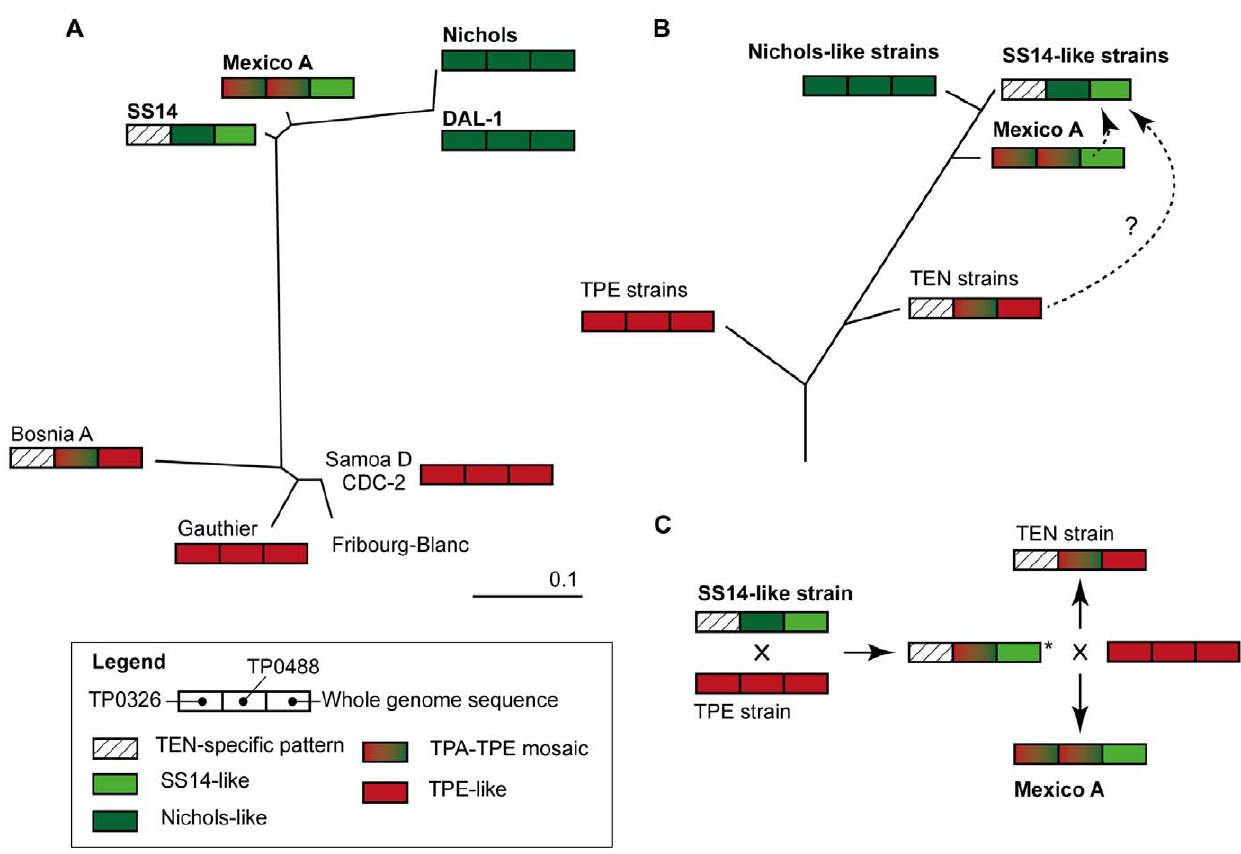
Figure 3. Evolutionary relationships among TP strains and hypothetical evolutionary schemes. A. Unrooted tree constructed from restriction target site data from 25.6% of the analyzed TP genomes (modified according to Sˇmajs et al. [18]). TPA (Dallas, Nichols, Mexico A and SS14), TPE (CDC-2, Gauthier and Samoa D), TEN (Bosnia A) strains and unclassified simian isolate Fribourg-Blanc were analyzed. TPA strains are shown in bold. Patterns shown for the Bosnia A strain are based on the sequences of TP0326 (GenBank acc. no. JX392330.1, this sequence is identical to partial sequence published by Harper et al. [19]) and TP0488 (GenBank acc. no. JX392331.1) determined by us, and on the whole genome fingerprinting data [18]. B. Scheme illustrating hypothetical evolution of TP strains. Please note that the ancestral position of Mexico A related to other TPA strains does not explain presence of TEN-specific pattern in TP0326 ( tp92 ) locus in the SS14-like group of TPA strains. C. Scheme illustrating hypothetical recombinations among TP strains. A hypothetical ancestor of TEN and Mexico A strains is marked by star.